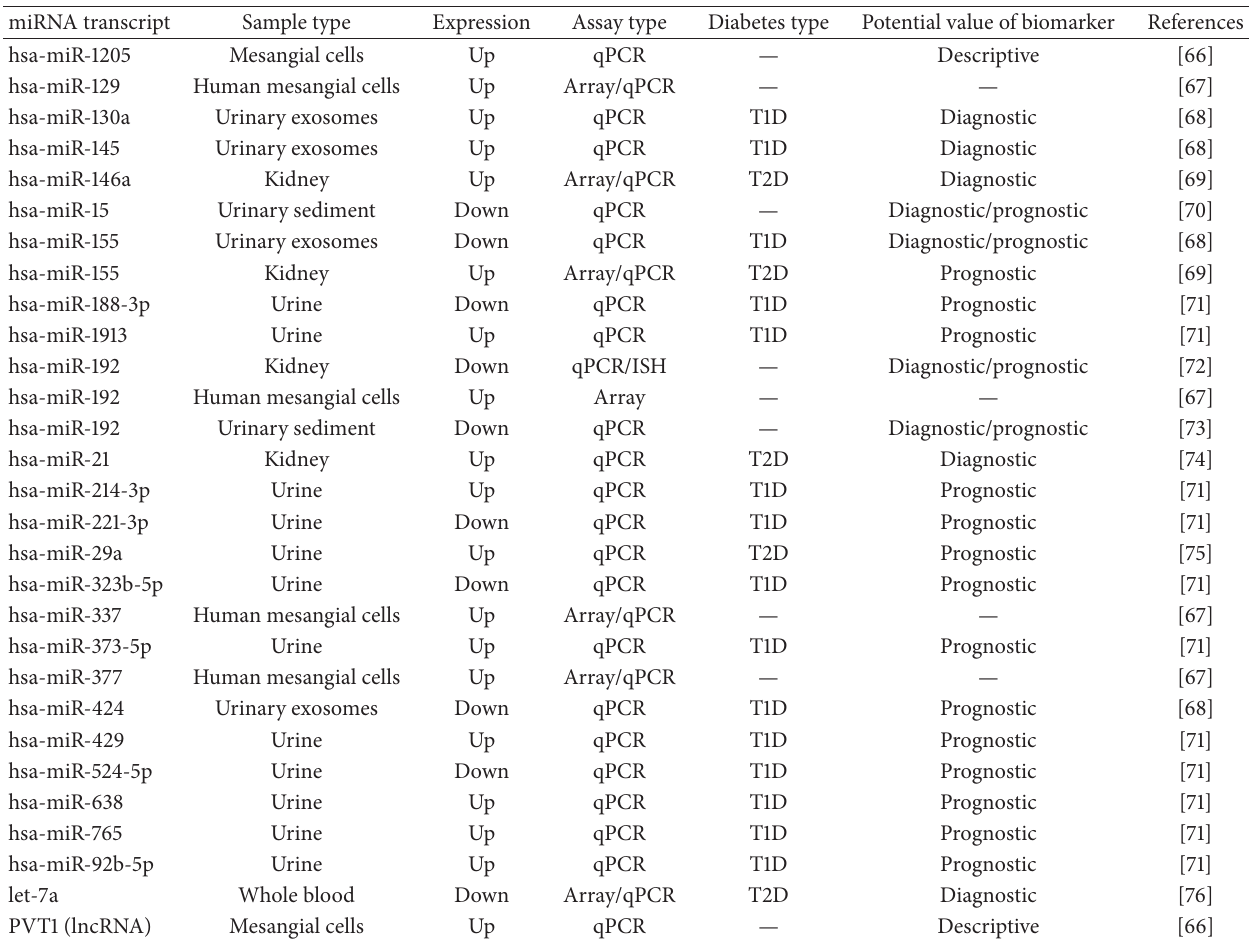
Table 3: Noncoding RNA markers. Collection of noncoding RNA transcripts deregulated in DN samples. List is ordered alphabetically. miRNA